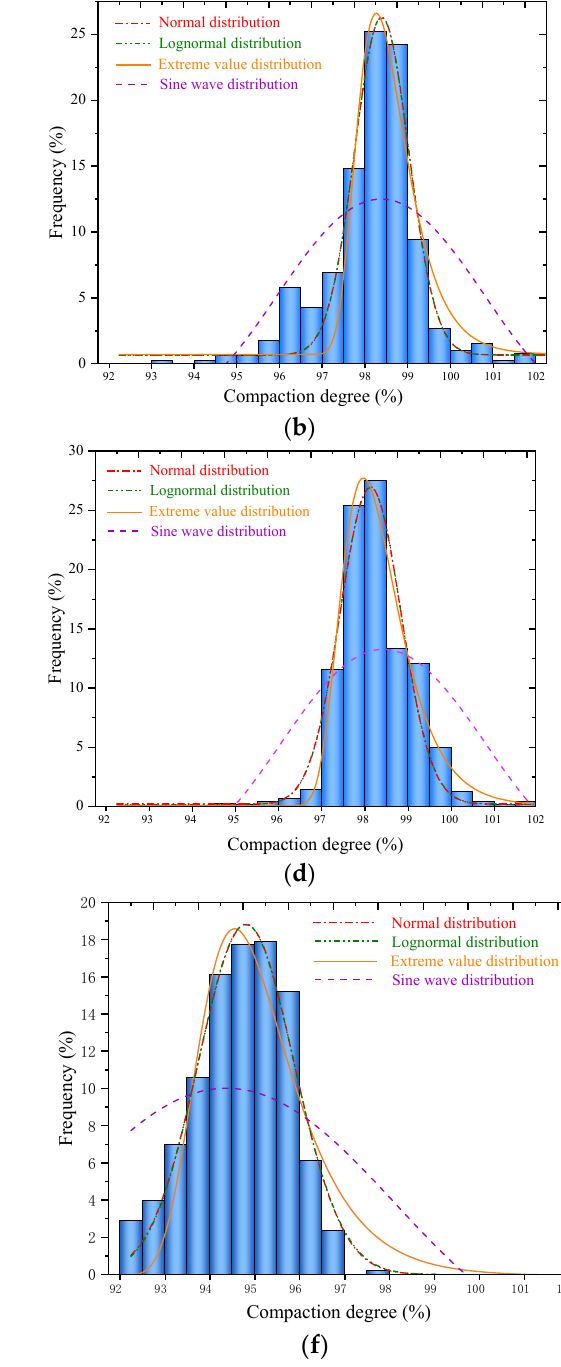
Figure 8. Frequency ‐ distribution histogram of compaction degree: ( a ) test section A; ( b ) test section